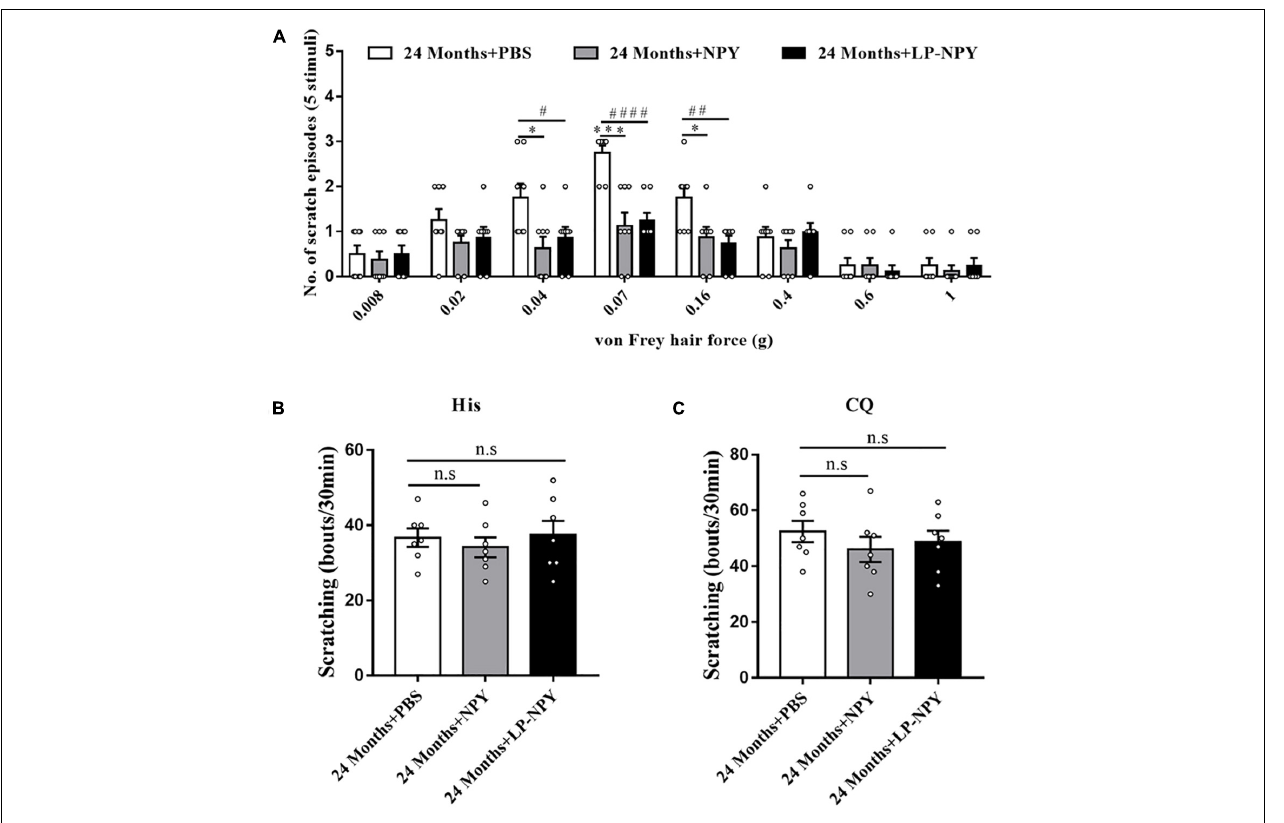
FIGURE 4 | Activation of spinal NPY1R alleviated the mechanical itch in aged mice. (A) Alloknesis scores in 24 months + PBS ( n = 8), 24 months + NPY ( n = 8, 4 male and 4 female), and 24 months + LP-NPY ( n = 8, 4 male and 4 female) mice. ∗ P < 0.05, ∗∗∗ P < 0.001, 24 months + PBS versus 24 months + NPY, Student’s t test; # P < 0.05, ## P < 0.01, #### P < 0.0001, 24 months + PBS versus 24 months + LP-NPY, Student’s t -test. (B) Scratching responses to intradermal injections of histamine in 24 months + PBS ( n = 7, 4 male and 3 female), 24 months + NPY ( n = 7, 4 male and 3 female), and 24 months + LP-NPY ( n = 7, 4 male and 3